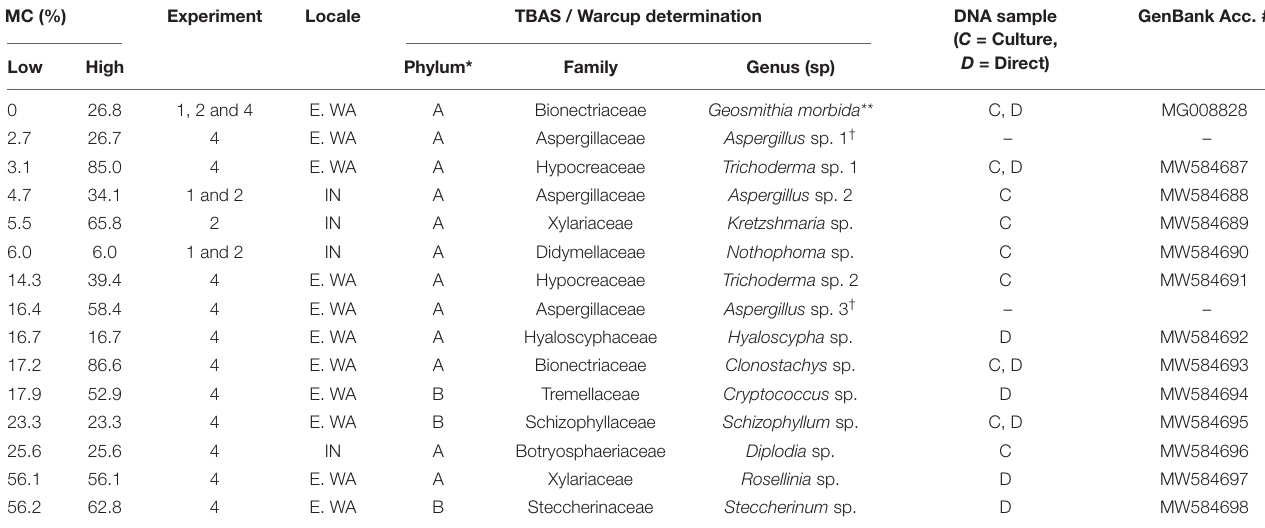
TABLE 2 | Final MC range, molecularly and/or morphologically inferred taxonomy, and GenBank accession numbers for DNA extracted directly (D) and/or from cultures (C) from fungi growing on wood disks in competition